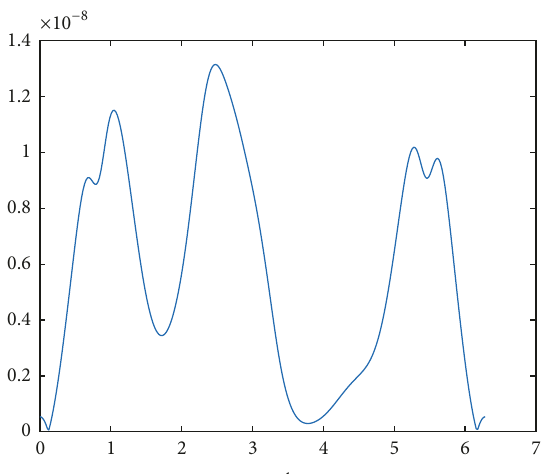
Figure 4: Domain in Example 3.